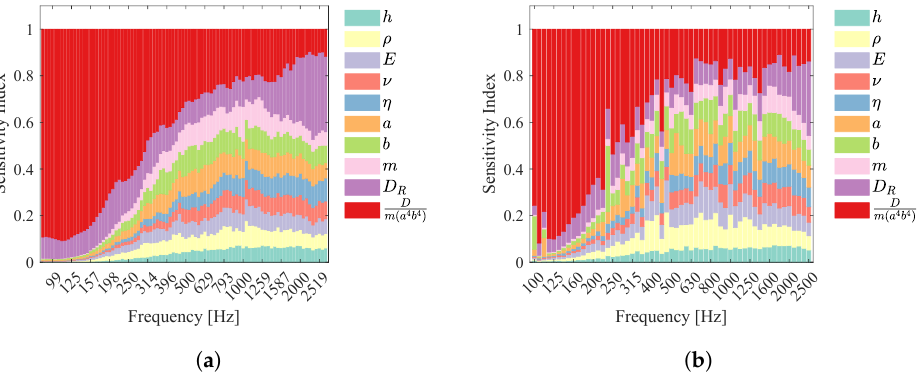
Figure 9. MDI-based sensitivity of the STL of finite plates including mass density m , the real part of bending stiffness D R and the resonance coefficient term R as physics-guided features: ( a ) sensitivity indices from MS dataset ( RMSE = 2.67 ± 0.02 dB); ( b ) sensitivity indices from FEM dataset ( RMSE = 4.86 ± 0.05